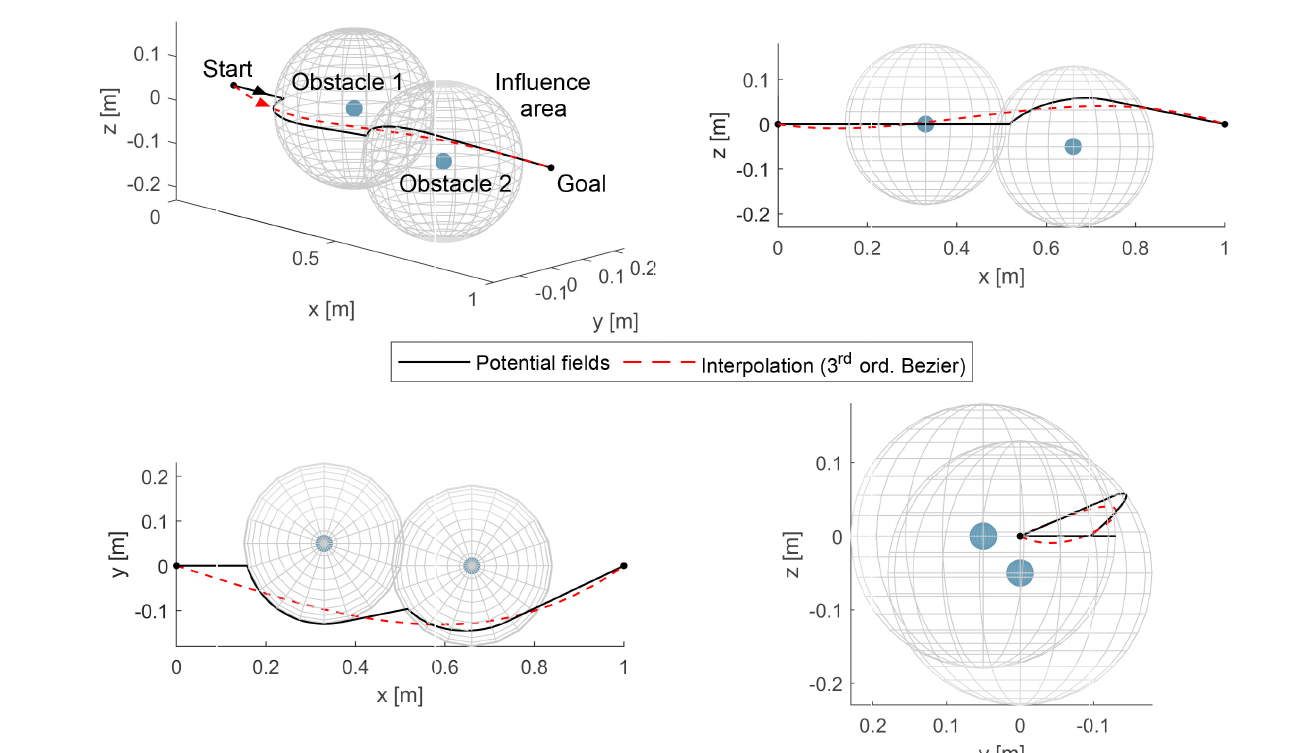
Figure 2. Example of path planning in 3D space with two